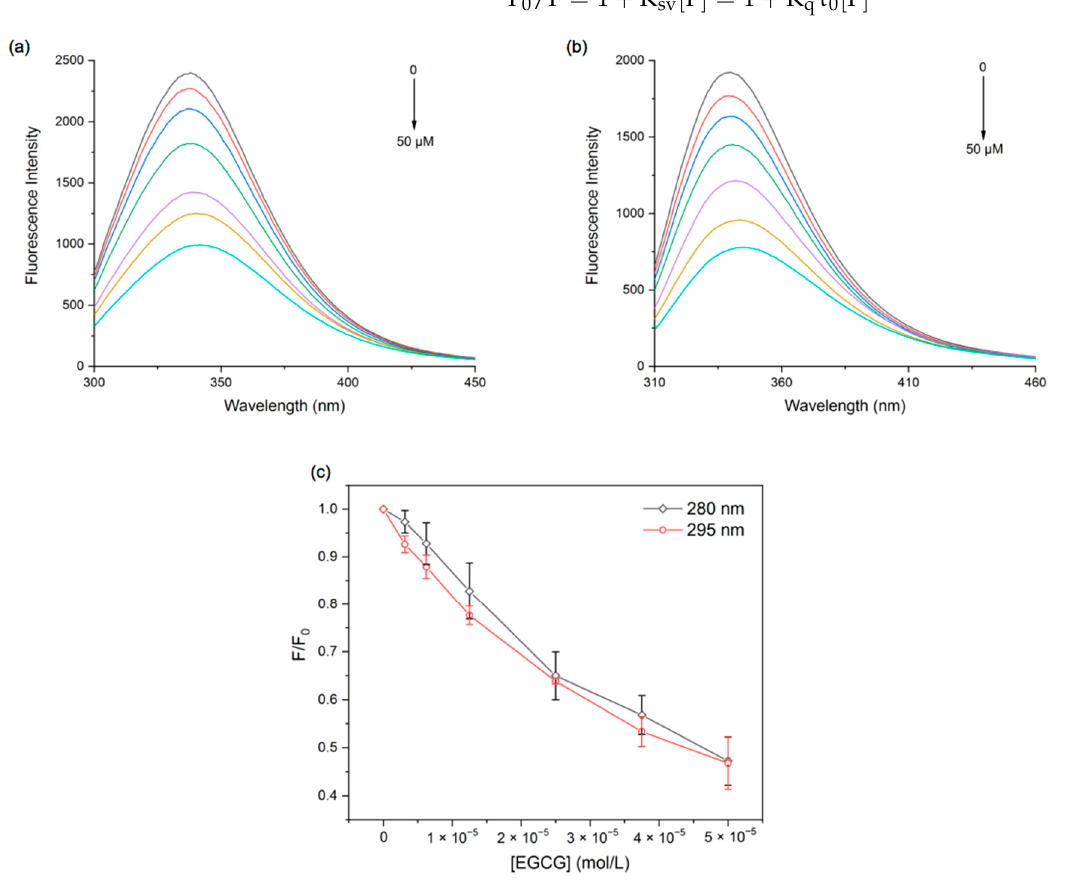
Figure 1. Fluorescence emission spectra of PPI at excitation wavelengths of 280 nm ( a ) and 295 nm ( b ), and fluorescence quenching spectra plots of PPI at 298 K ( c ) with different EGCG concentrations.